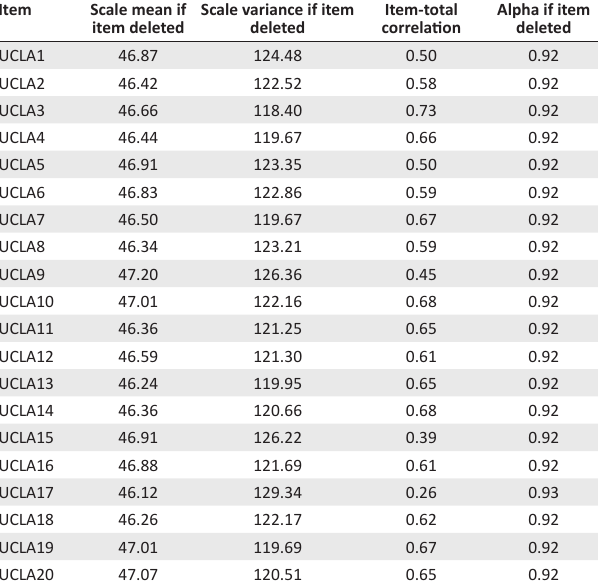
TABLE 2: Item groupings for the one-factor and two bifactor models. Item One-factor Bifactor: two